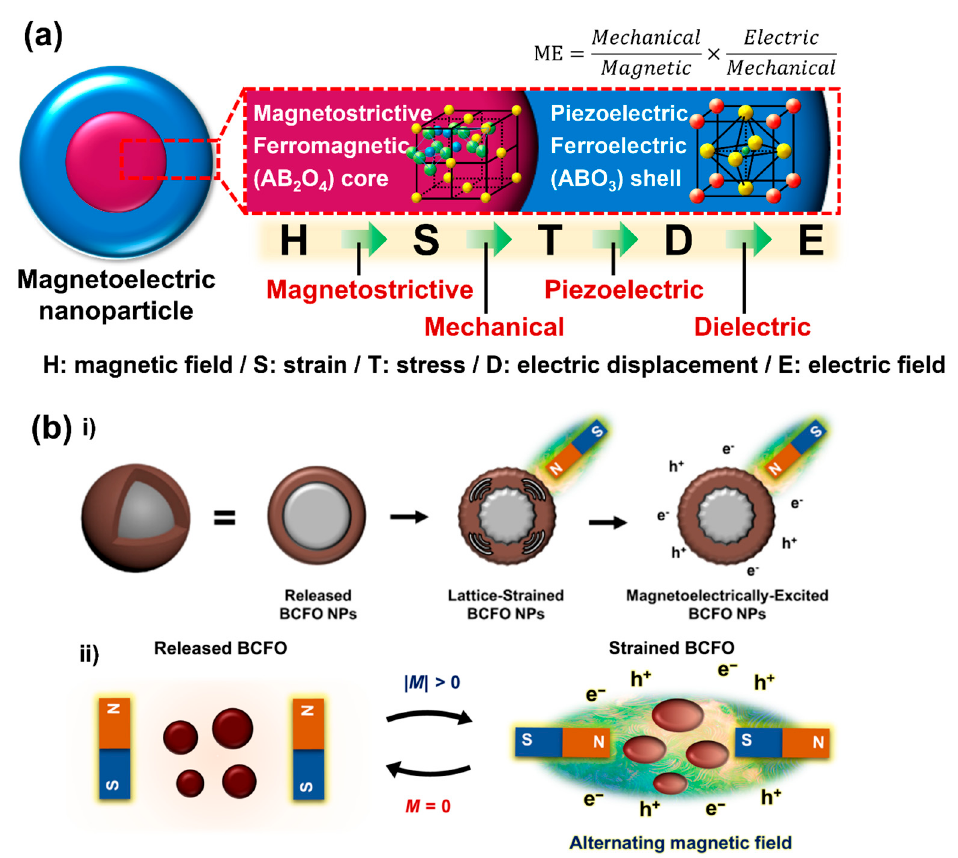
Figure 2. Magnetoelectric (ME) effect of MENPs. ( a ) Concept of physics; transmission mechanism through ME effect in the MENPs composed of the magnetostrictive core and piezoelectric shell. ( b ) (i) The schematic illustration showing that MENPs induce an ME effect when an alternating magnetic field is applied. (ii) Repeatedly induced strain and release of the MENPs dependent on the magnetic moments of the applied magnetic field. Reproduced with permission from [59]. Copyright 2022, Science.